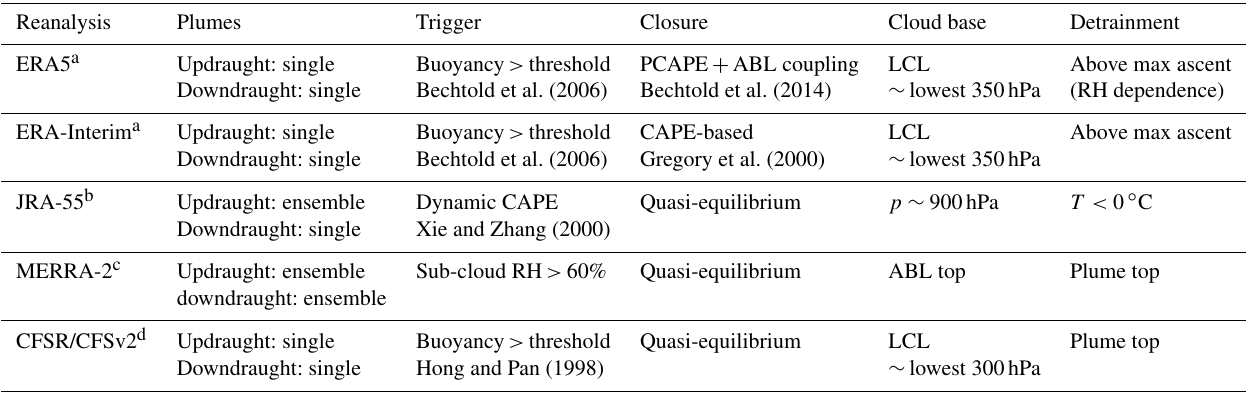
Table A1. Summary information on deep convective parameterizations used in the reanalyses. Here CAPE is convective available potential energy, PCAPE is an entraining CAPE evaluated in pressure coordinates (Bechtold et al., 2014), LCL is the lifting condensation level, ABL is the atmospheric boundary layer, and A–S stands for